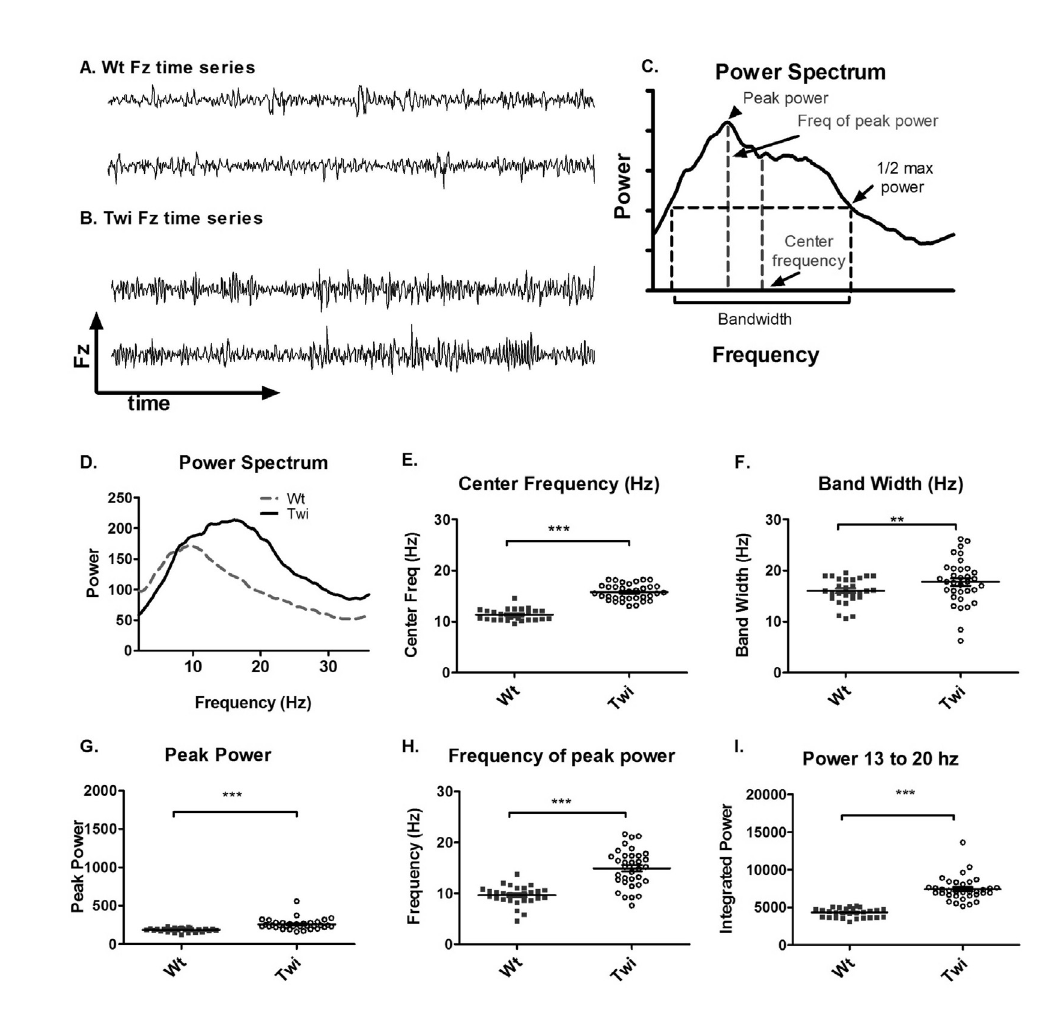
Figure 1. Characterization of tremor in the Twi mice. Representative Fz time series recording from a Wt mouse ( A ) and a Twi mouse ( B ) over 12 seconds (each series is 6 s). The X-axis represents time and the Y-axis represents force the vertical force variation (Fz) recorded by the force plate actometer. A Fourier transformation performed on the Fz time series data yields a power spectrum that shows how much power (variance) the Fz variation contains at each frequency of oscillation. The power spectrum can then be further analyzed to yield peak power, frequency at peak power, center frequency, and bandwidth. These data are represented diagrammatically on a hypothetical power spectrum plot ( C ). The averaged power spectrum ( D ) of the Twi mice (solid black line) was shifted towards higher frequencies compared to the Wt mice (dashed gray line). The center frequency ( E ) was significantly increased in the Twi (open circles) compared to the Wt mice (filled squares). There was a significant increase in the band width ( F ) in the Twi compared to the Wt group. The peak power ( G ), frequency at peak power ( H ) and the power between 13 and 20 Hz (I) were significantly increased in the Twi group compared to the Wt group. The horizontal bars represent the mean and the error bars represent the SEM (*** p < 0.001, ** p <